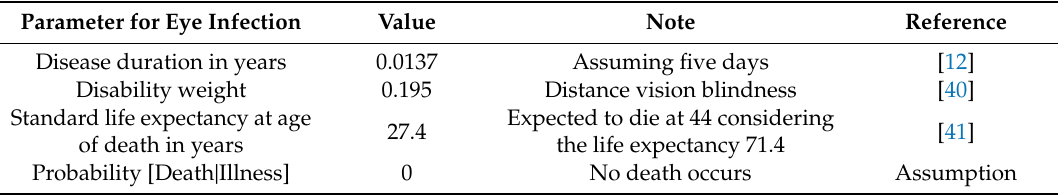
Table 1. DALYs input parameters for Pseudomonas aeruginosa.